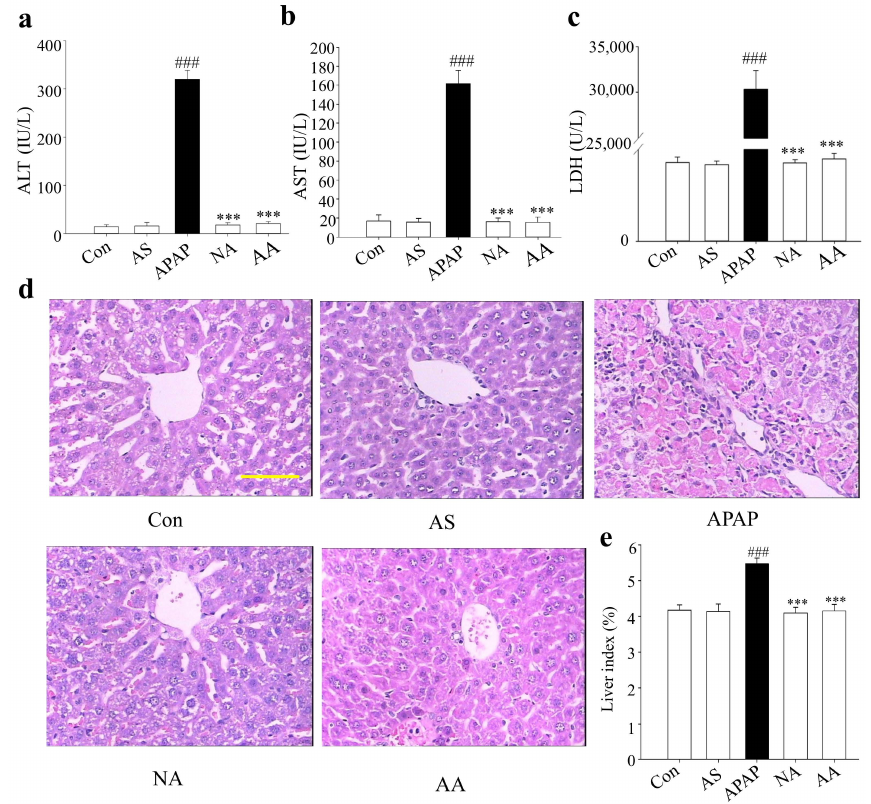
Figure2. PretreatmentofAuriculatonesulfate(AS)preventsmicefromAcetaminophen(APAP)-induced acute liver injury. Control group (Con), AS (50 mg / kg)-treated group (AS), APAP (300 mg / kg)-treated group (APAP), AS (50 mg / kg) / APAP (300 mg / kg)-treated group (AA), N -acetyl cysteine (NAC) (1000 mg / kg) / APAP (300 mg / kg)-treated group (NA). ( a ) Serum alanine aminotransferase (ALT) levels. ( b ) Serum aspartate aminotransferase (AST) levels. ( c ) Serum lactate dehydrogenase (LDH) levels. ( d ) Representative histological staining (H&E) of liver tissue (400 × ), scale bar: 10 µ m. ( e ) Liver index. Data are expressed as means ± SD ( n = 10). ### p < 0.001 compared to Con group; *** p < 0.001 compared to APAP